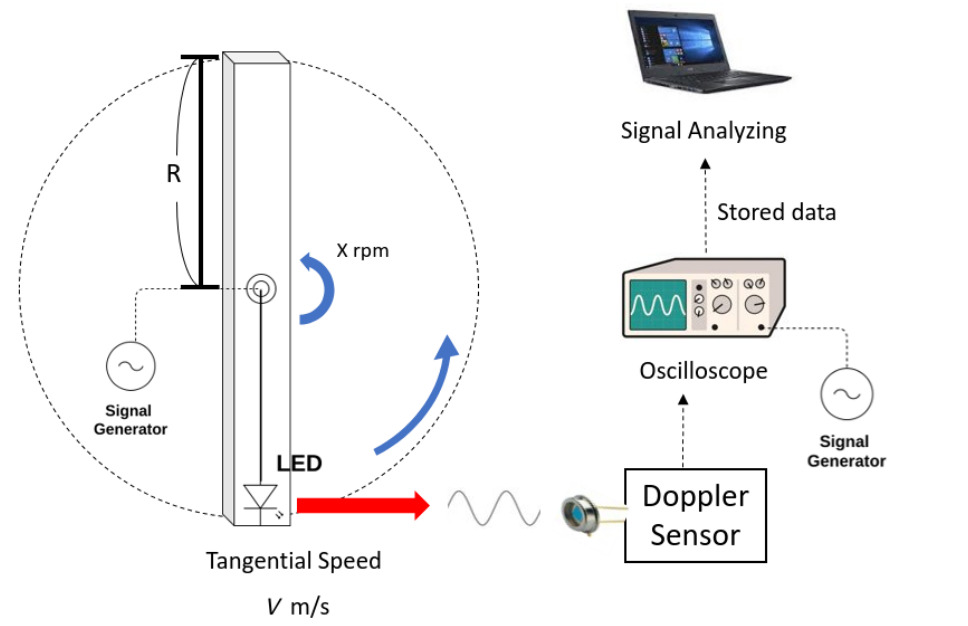
Figure 9. Schematic of the experiment setup for experimental testing of the Doppler rate sensor: The rotating wheel provides high tangential speed relative to the